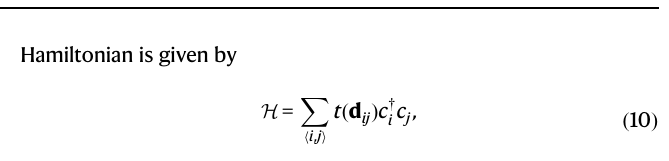
Fig. 5 | Gate control of the TR-even Hall effect in 2 ∘ tMoTe 2 . a – c Valence bands from +K valley, and d TR-even Hall conductivities with different interlayer bias V z . Color coding in a – c denotes the layer composition l z n ð k Þ . The gray shaded area in